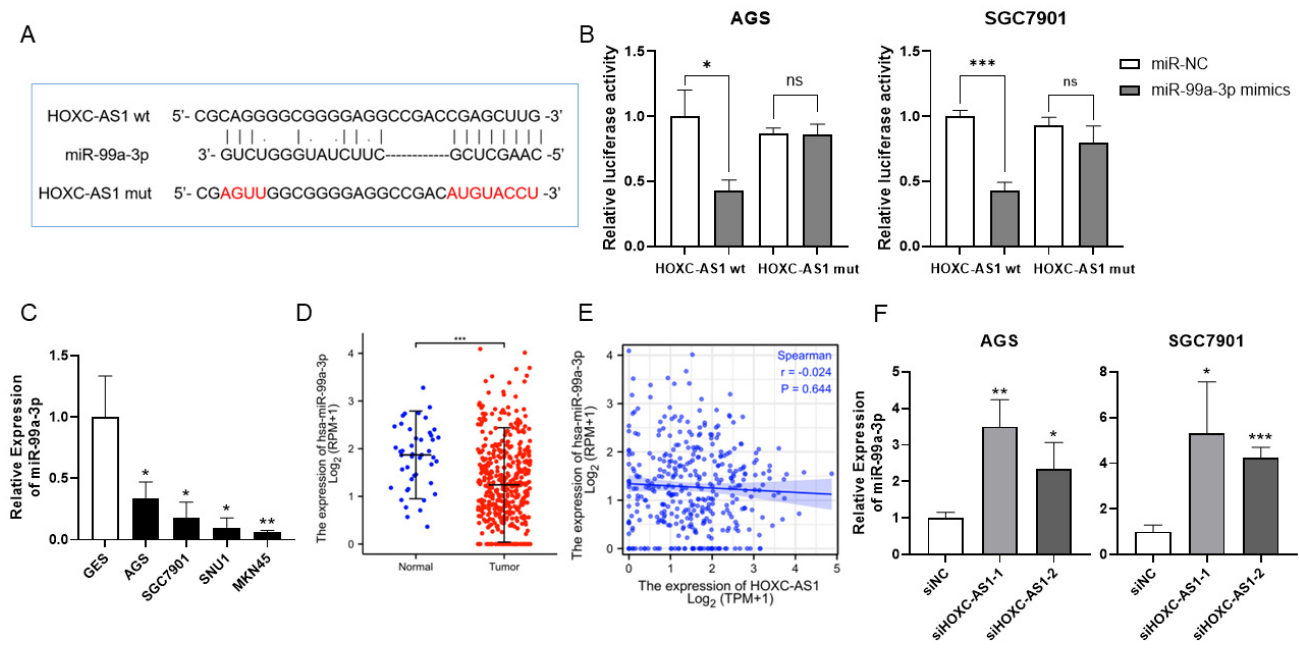
Figure 3. HOXC-AS1 sponged miR-99a-3p in GC. ( A ) The predicted binding site of HOXC-AS1 and miR-99a-3p using DIANA tools. ( B ) Interaction between HOXC-AS1 and miR-99a-3p detected by the dual-luciferase reporter gene assay in AGS and SGC7901 cell lines. ( C ) MiR-99a-3p expression of in GES, AGS, SGC7901, SNU1 and MKN45 by qRT-PCR. ( D ) MiR-99a-3p expression in normal and tumorous gastric tissues from TCGA. ( E ) The correlation between HOXC-AS1 and miR-99a-3p. ( F ) MiR-99a-3p expression after downregulating HOXC-AS1 by qRT-PCR. ns represents no signifi- cance. * p < 0.05; ** p < 0.01; *** p < 0.001.